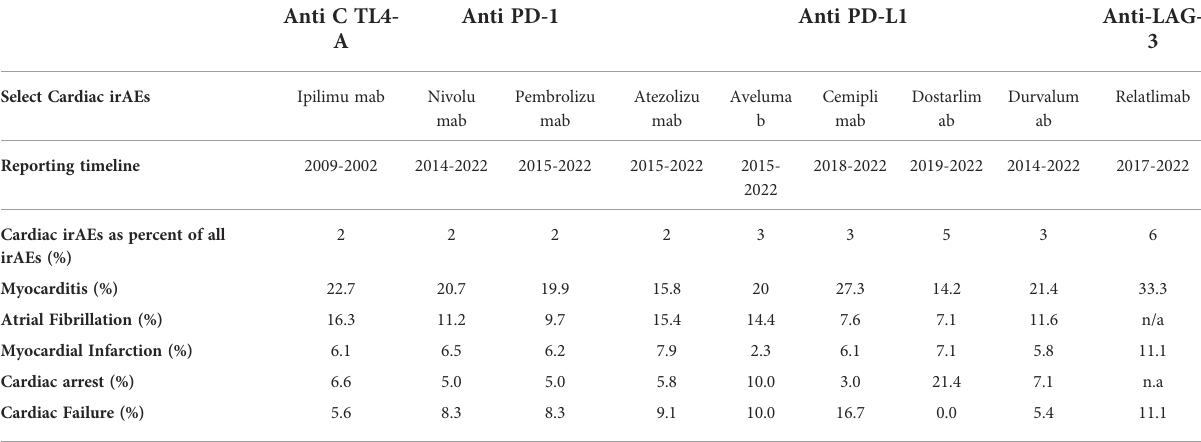
TABLE 2 Select cardiac pathology as a percentage of overall cardiac irAEs reported on Vigibase for each ICIs as of 2022 (VigiAccess, July 2022)